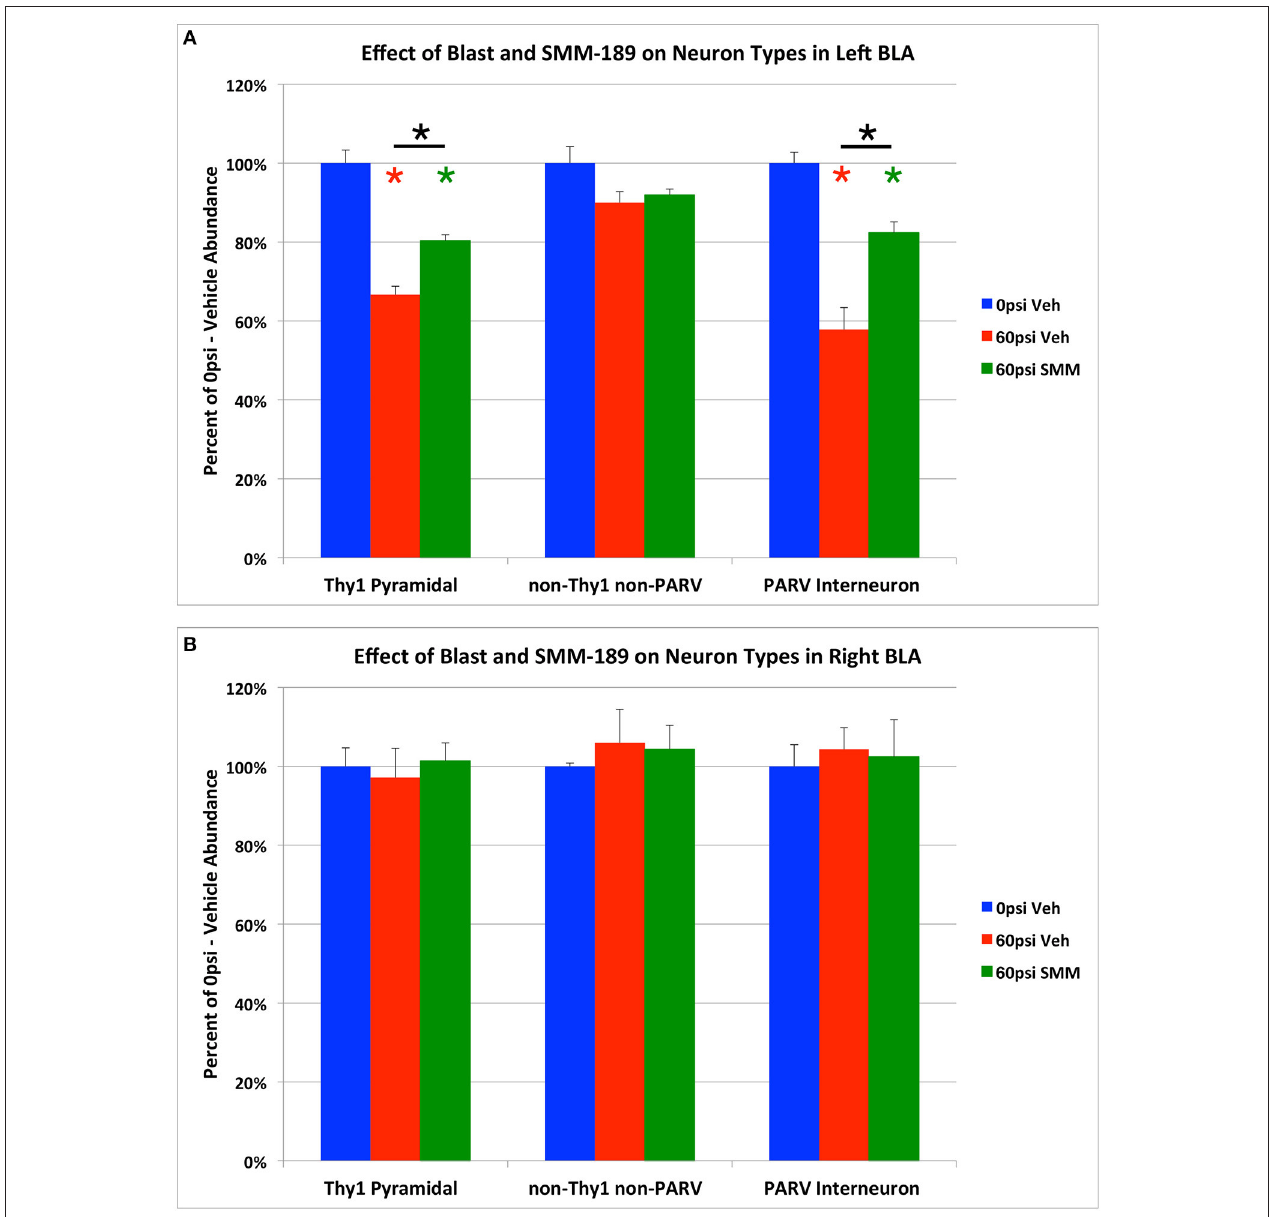
FIGURE 7 | Graphs showing the effect of TBI and SMM-189 on neuron types in left BLA (A), and in right BLA (B). Thy1 + pyramidal neurons and PARV + interneurons are decreased in number in the left BLA of 60-psi blast mice, and are both rescued in the SMM-189 treated mice. By contrast, there was no significant change in the non-Thy1/non-PARV neurons of left BLA (which are mainly fear-promoting pyramidal neurons) of BLA after TBI. Red asterisks indicate a significant difference between vehicle-treated 60-psi mice and vehicle-treated 0-psi mice. Green asterisks indicate a significant difference between SMM-189 and vehicle-treated 0-psi mice. Asterisks above bars spanning the SMM-189 and vehicle-treated 60-psi mice columns indicate a significant difference between these two conditions. No significant changes in Thy1 + pyramidal neurons, PARV + inhibitory interneurons, or non-Thy1/non-PARV neurons were seen for the right BLA following TBI, with or without treatment (B)